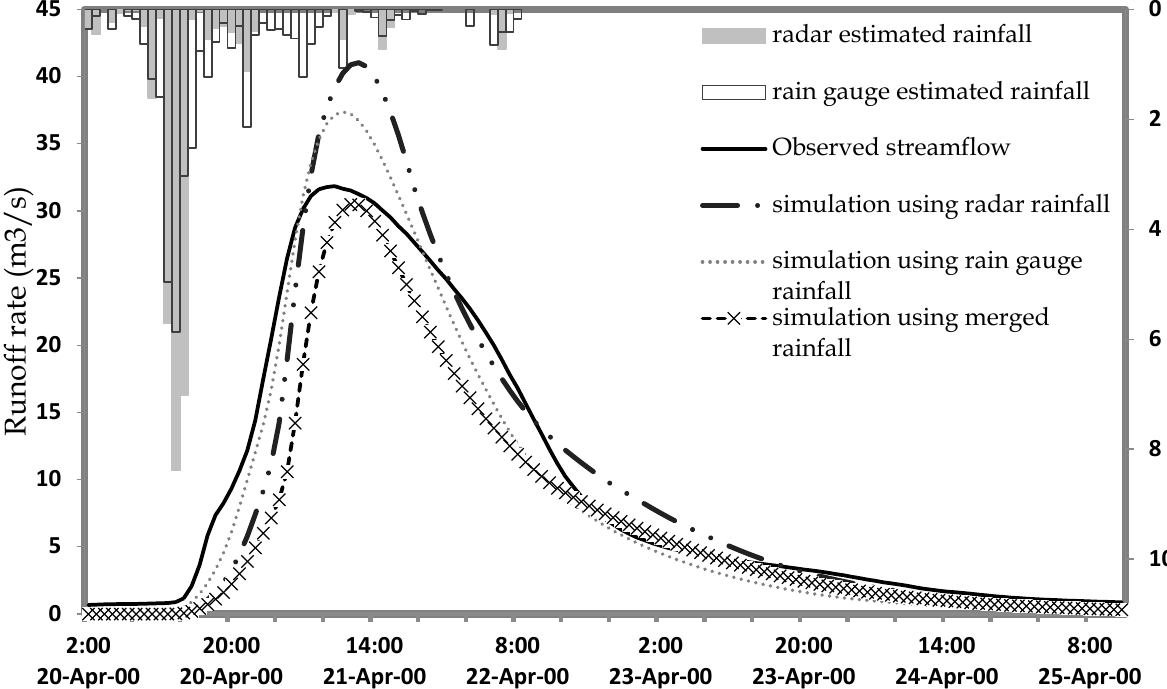
Figure 18. Comparison of estimated and observed hydrographs using different rainfall estimates for the 20 April 2000 event with Green and Ampt modeling option.